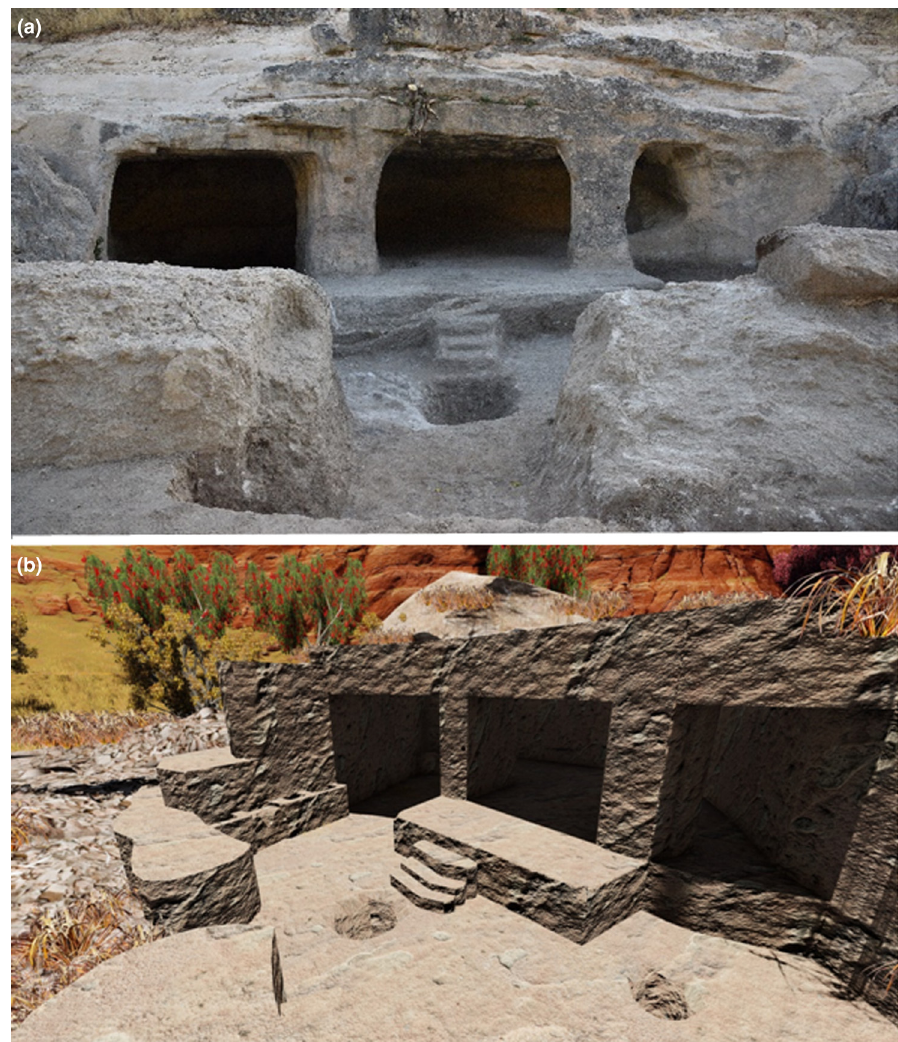
Figure 15: Photograph ( a ) and 3D restitution ( b ) of the rock dwelling ( Ambarçay Salvage Excavation Archive )